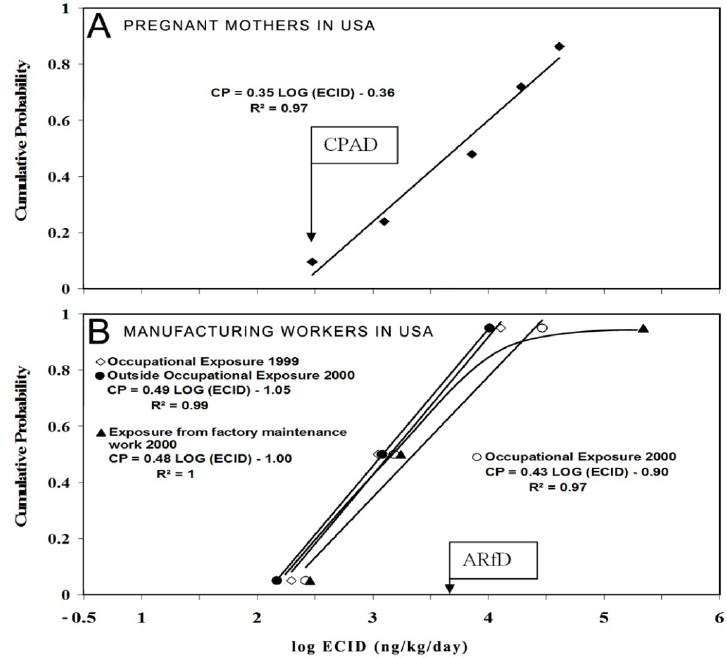
Figure 3. Cumulative probability distributions (CPD) for the ECID with the